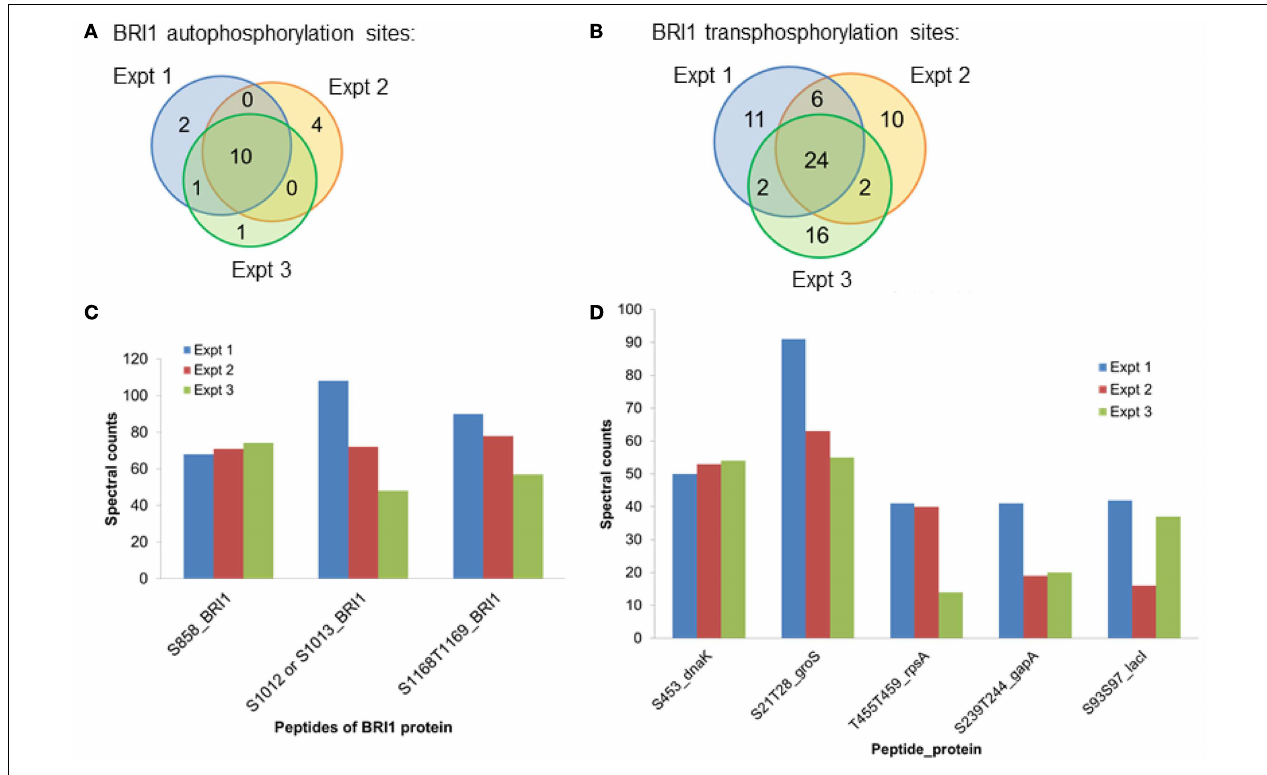
identified BRI1 transphosphorylation peptides from three biological replicates.Twenty-four abundant BRI1 transphosphorylation peptides were commonly identified. (C) The reproducibility of spectral counts of three most abundant BRI1 autophosphorylation peptides usingTiO 2 enrichment. (D) The reproducibility of spectral counts on the five most abundant BRI1 transphosphorylation peptides usingTiO 2 enrichment. Note that phosphopeptides are identified using the single letter abbreviations for Ser (S) andThr